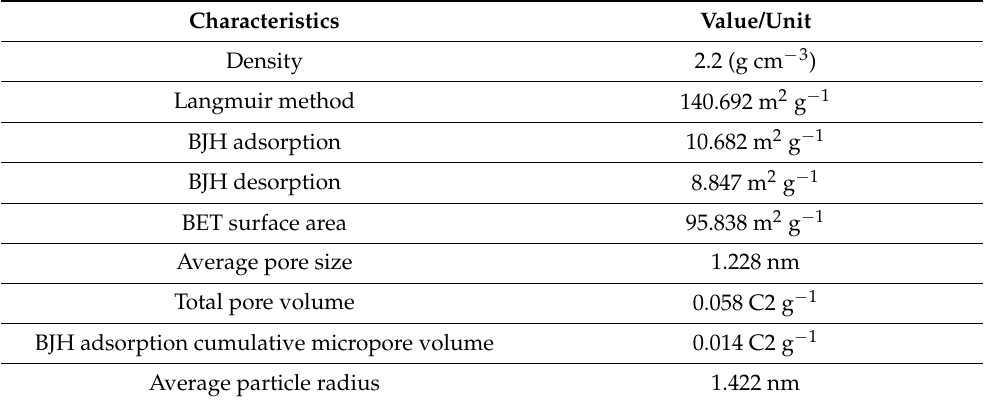
Figure 2. BET specific surface area ( A ) and adsorption ‐ desorption isotherm examination ( B ) of ZnO ‐ ZnO-NPs. NPs. Table 2. Physicochemical properties of Table 2. Physicochemical properties of ZnO ‐ NPs.